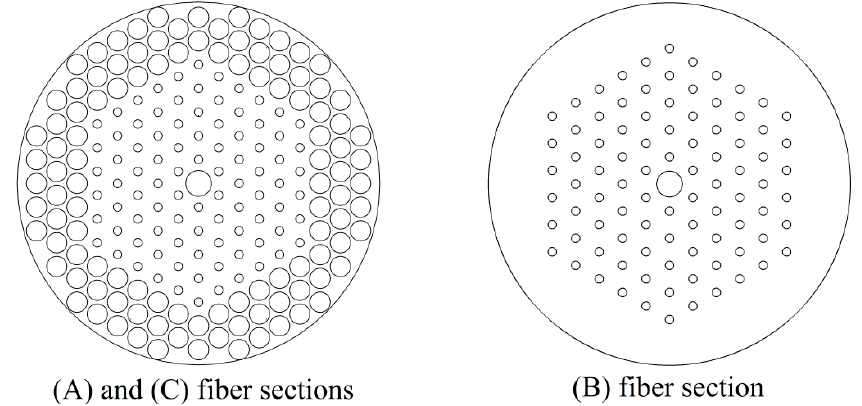
Figure 2. Transversal geometry of the three sensor sections: ( A ) Double cladding MOF with CLPGs inscribed within the core; ( B ) Single mode intermediate MOF; ( C ) Ytterbium-doped MOF laser cavity.